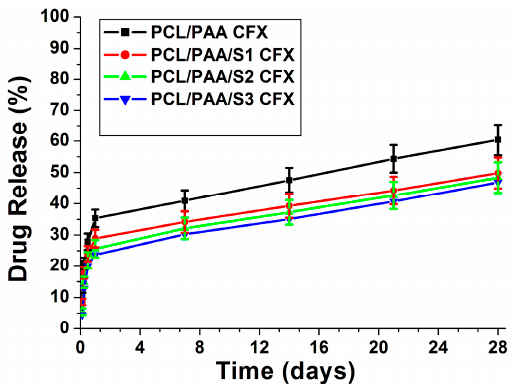
Figure 7. CFX release (%) from the silica microspheres loaded scaffolds after variant interval times of immersion in phosphate buffer saline (PBS) with reference to the silica microspheres free scaffold.